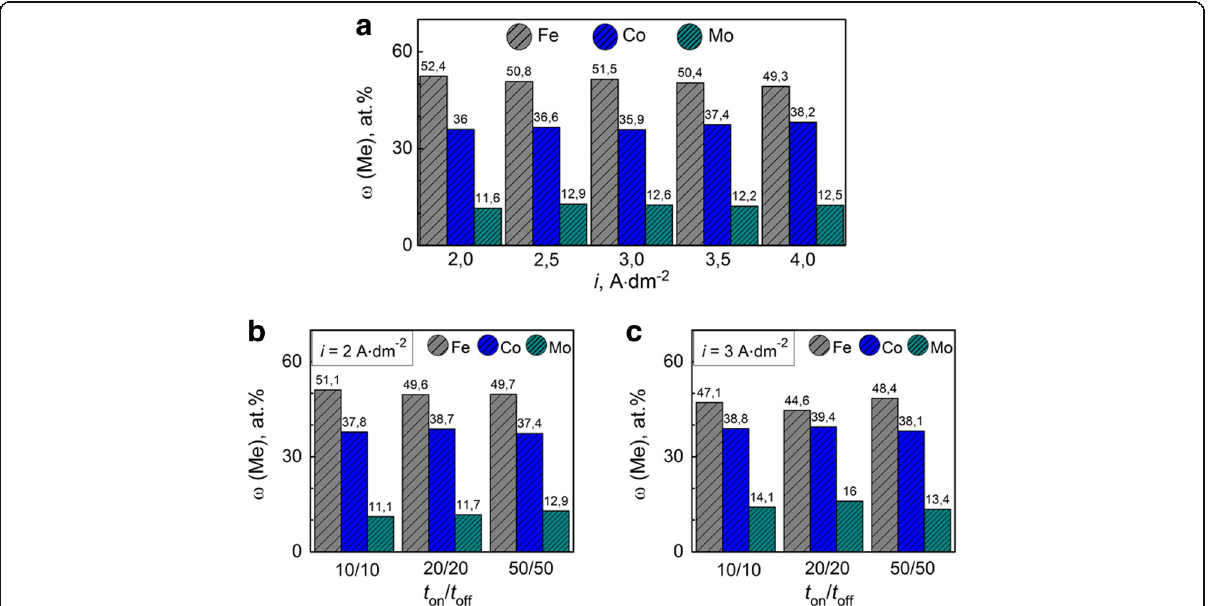
Fig. 4 Current density influence on the composition of Fe-Co-Mo alloys (thickness 10 μ m) deposited onto copper substrate. a Galvanostatic elec- trolysis. b , c Pulse mode